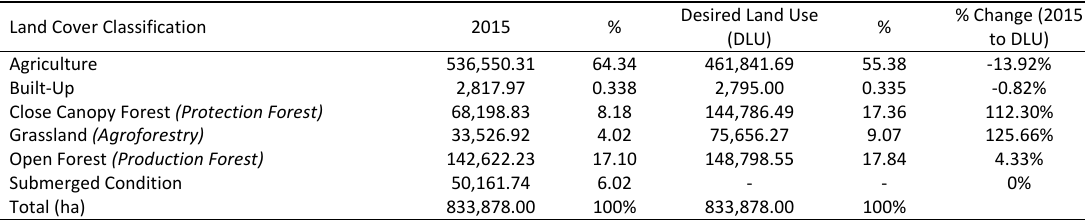
Table 4: Proportion and area of the desired land use